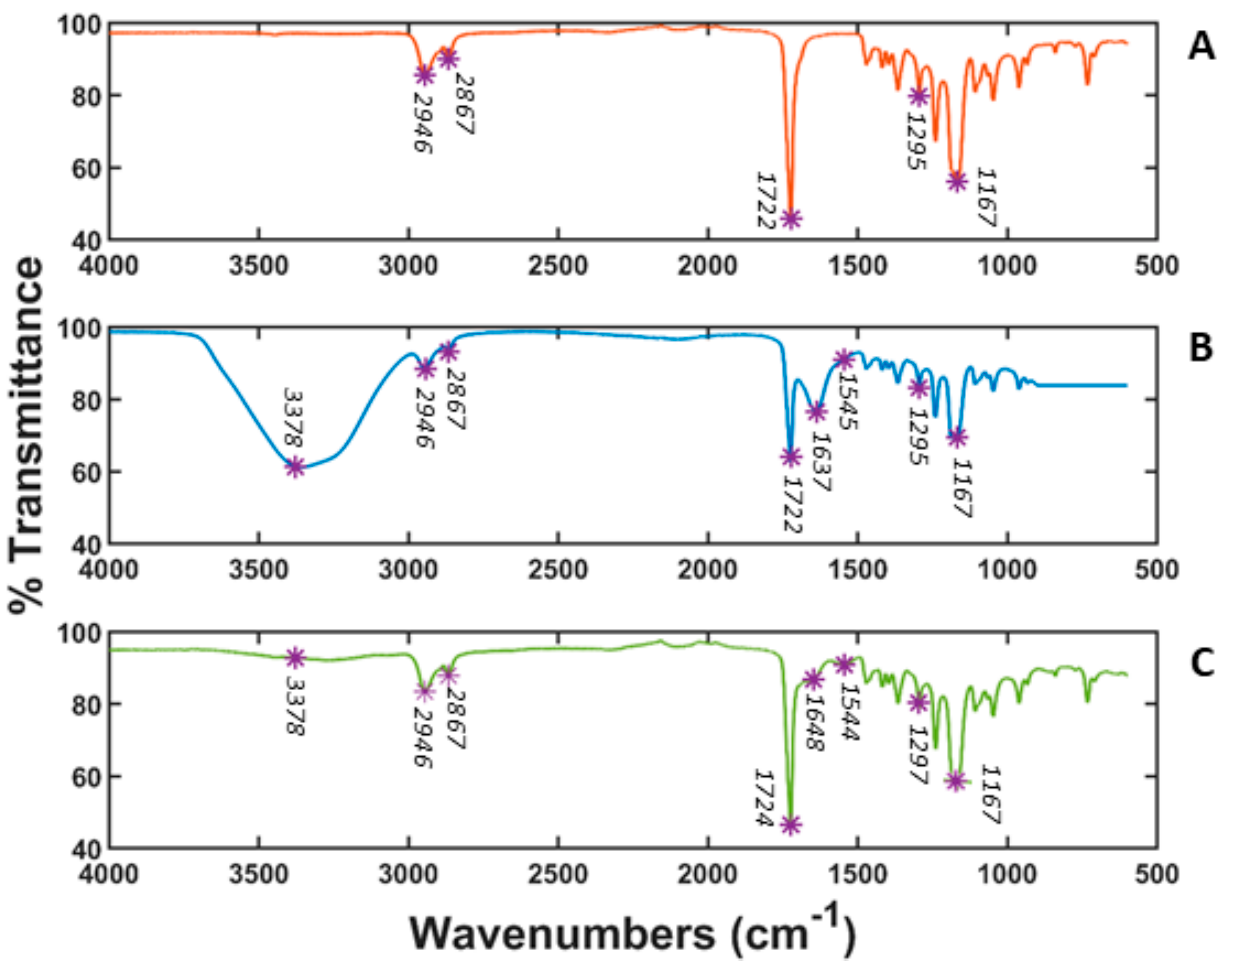
Figure 4. FT-IR of ( A ) PCL 10% scaffold ( B ) PCL 10% with gelatin coating and ( C ) PCL/gelatin 80:20 composite scaffold.